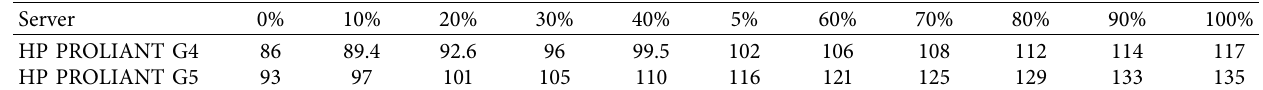
Table 4: Servers power consumption at different levels of workload per watt-hour.